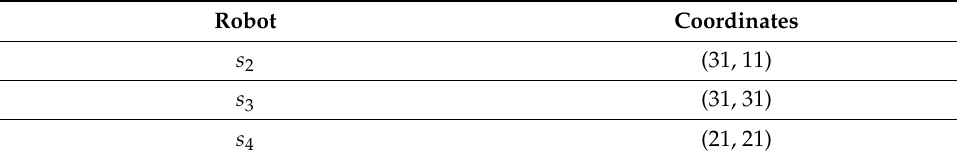
Table 6. Coordinates of idle and available charging